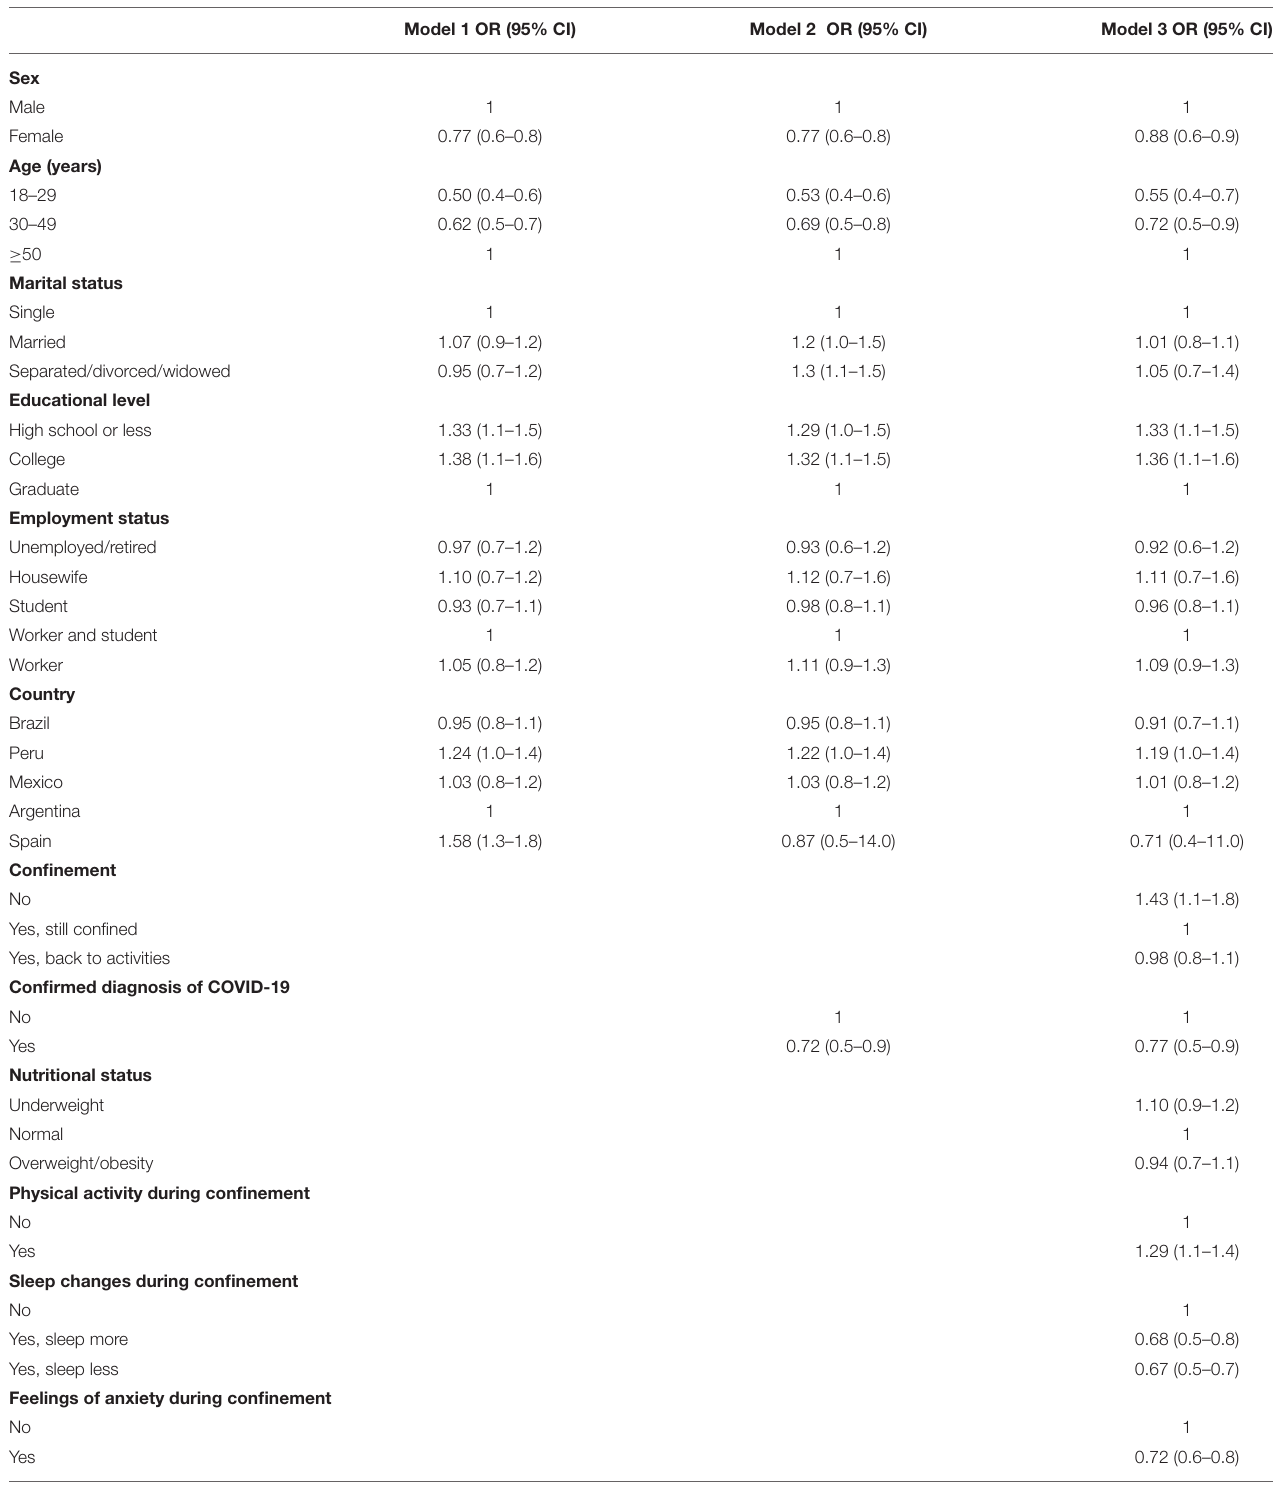
TABLE 4 | Comparison of selected variables among participants who remained constant on their eating pattern during the COVID-19 pandemic ( n = 3,849). a